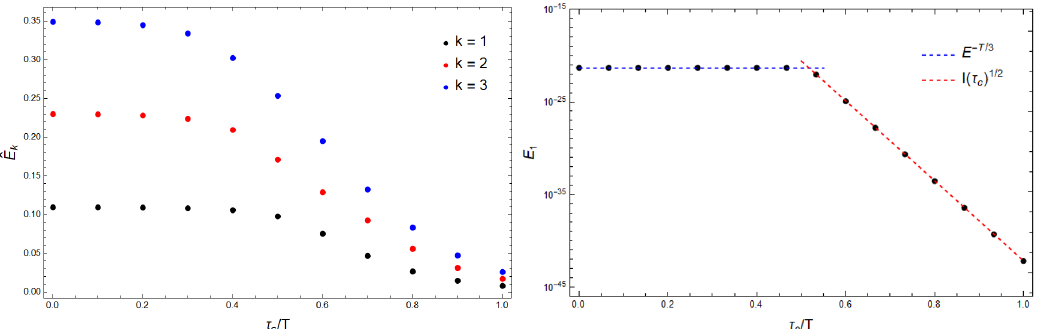
Figure 4 . (Left) Eigenvalues ˆ E k for the first 3 modes obtained by solving the Schrödinger equation numerically with V eff (3.12), for fixed T = 10 and different values of τ c ; (Right) Eigenvalues ˆ E 1 for the first excited mode obtained by solving the Schrödinger equation numerically with V eff (3.12), for fixed T = 150 and different values of τ c